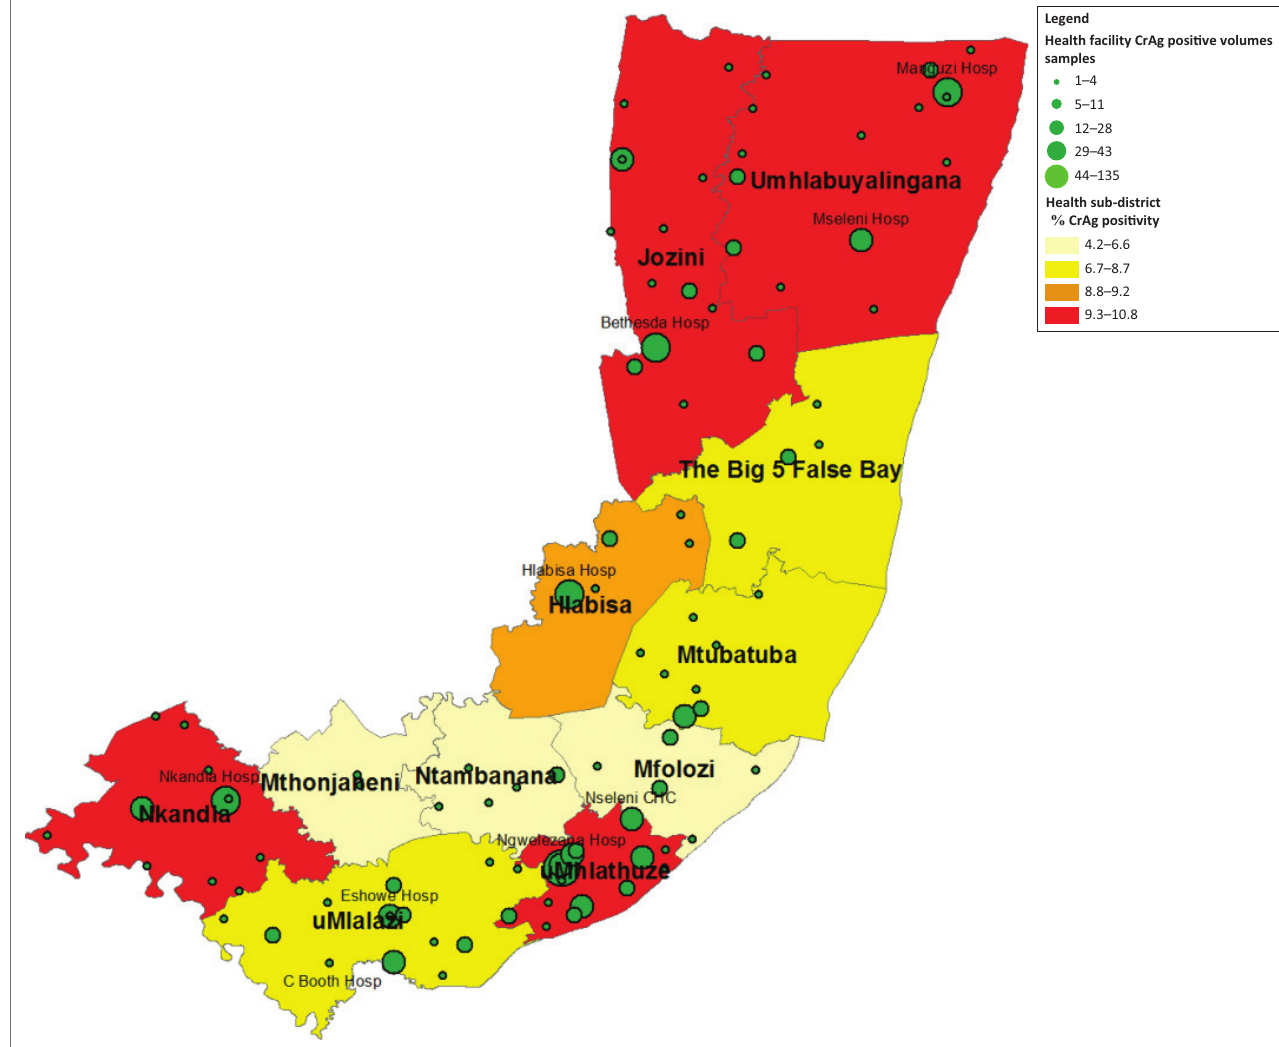
FIGURE 2: Spatial analysis of the CrAg positivity rate by sub-district for the King Cetshwayo and Umkhanyakude health districts with the number of positive CrAg samples by health facility reported across five